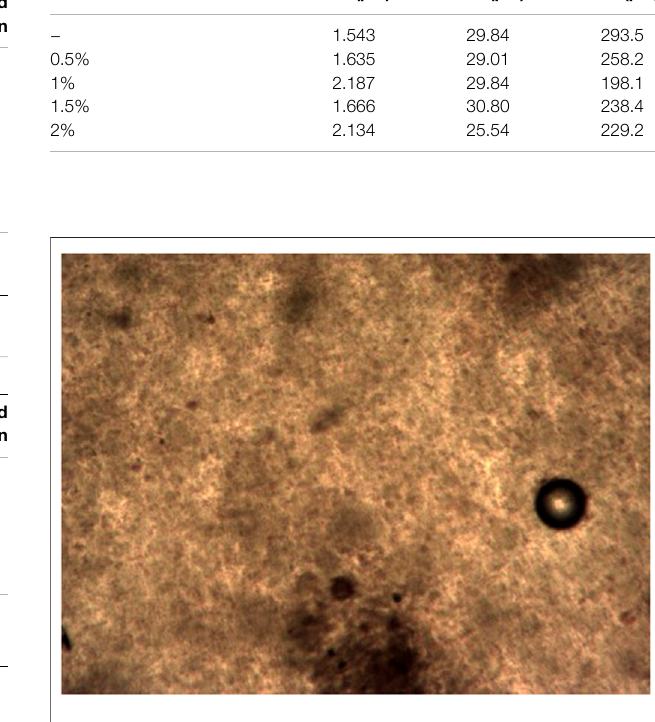
FIGURE 3 | Microscopic morphology of PEM drilling fl